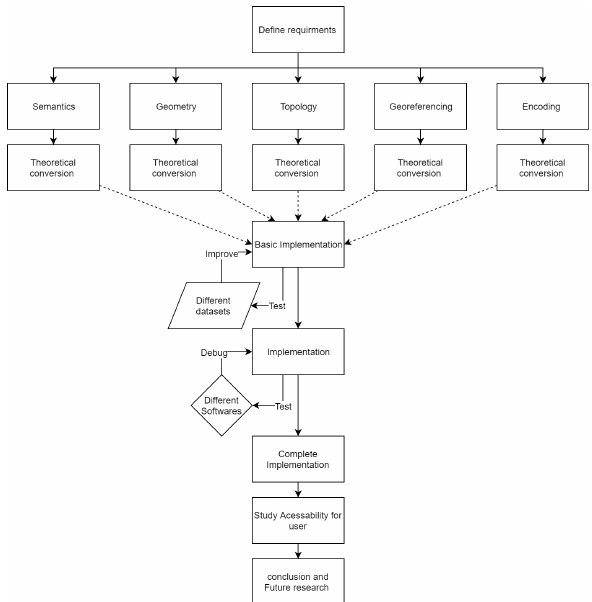
Figure 2. Overview of